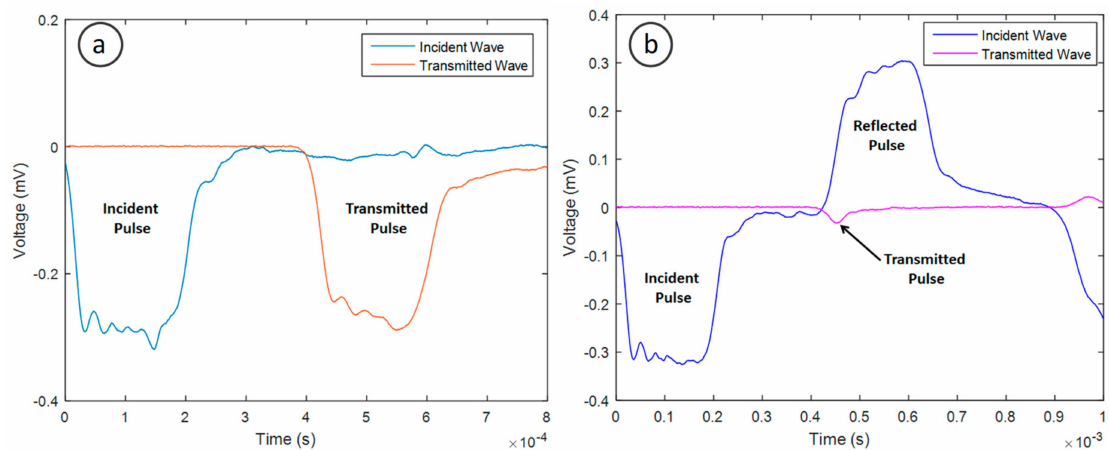
Figure 9. Incident and transmitted pulse for no sample condition ( a ) and incident, reflected and transmitted pulse for eucalyptus pellets in diametral orientation ( b ).